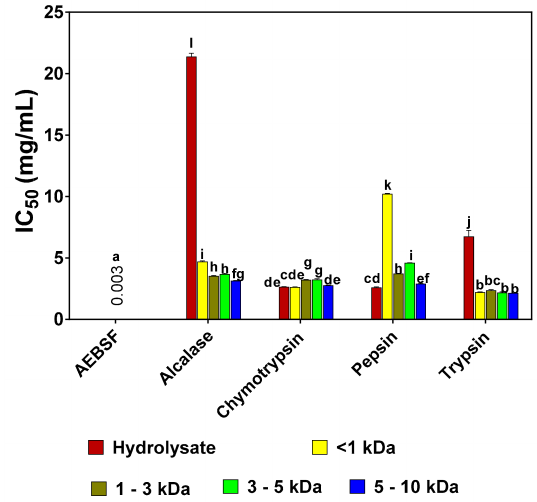
Figure 2. Inhibitory concentrations of 4-(2-Aminoethyl) benzenesulfonyl fluoride hydrochloride (AEBSF) in comparison to those of pea protein hydrolysates and peptide fractions that reduced trypsin activity by 50% (IC 50 ). Results are presented as mean ± standard deviation. Bars with di ff erent letters have significantly di ff erent ( p < 0.05) mean